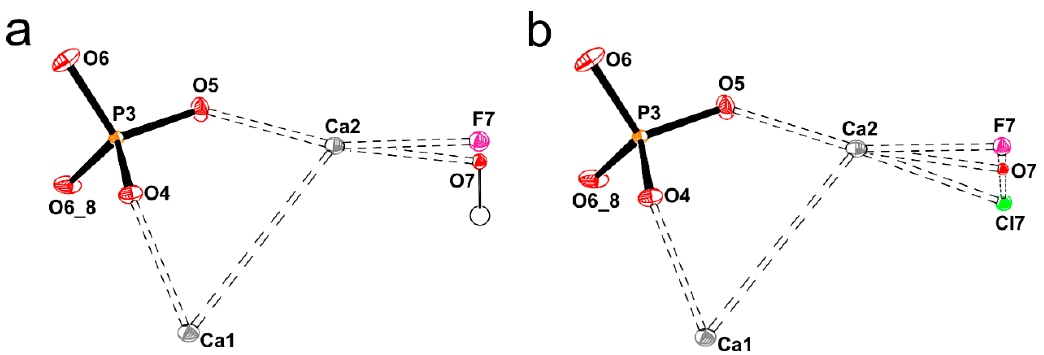
Figure A4. The drawing of the asymmetric unit contents of the apatites GAp ( a ) and YAp ( b ) with additional oxygen atom O6_8 to complete the phosphate group by the symmetry operation _8: x y z+½. The site occupancy factors of fluorine, chlorine atoms and hydroxyl groups are GAp 0.115(5) for F7, YAp 0.052(5) for O7, 0.091(2) for F7, 0.071(2) for O7 and 0.005(1) for Cl7.